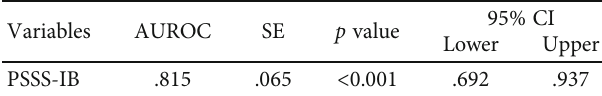
Figure 3: Area under receiver operating characteristic curve (AUROC) for participation restriction used cut of 31 of PSSS-Ina.